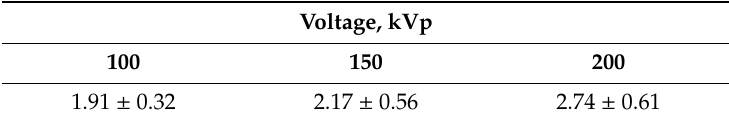
Table 3. Sensitizer enhancement ratio (SER) values for di ff erent voltages on the X-ray tube in the presence of 2.4 mg / mL of 26 nm